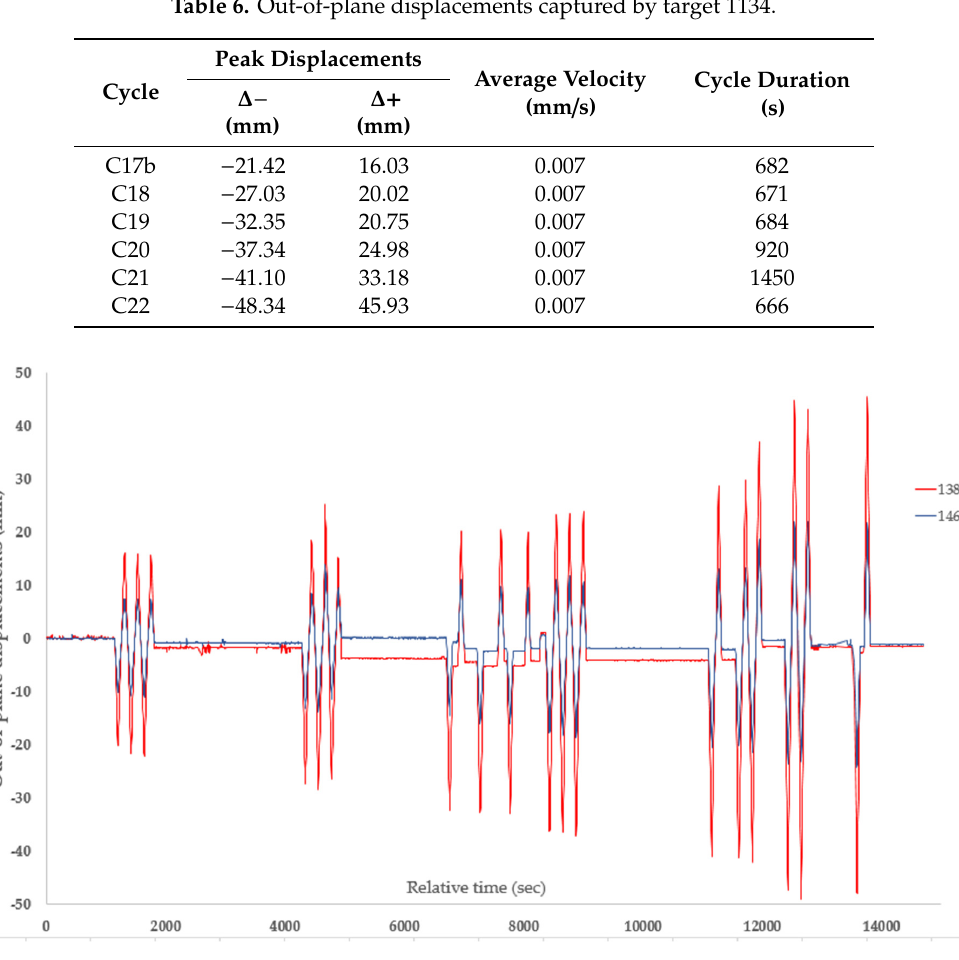
Figure 9. Graphical representation of the out-of-plane displacements captured by the photogrammetric approach on targets 1386 and 1464. Table 6. Out-of-plane displacements captured by target 1134.